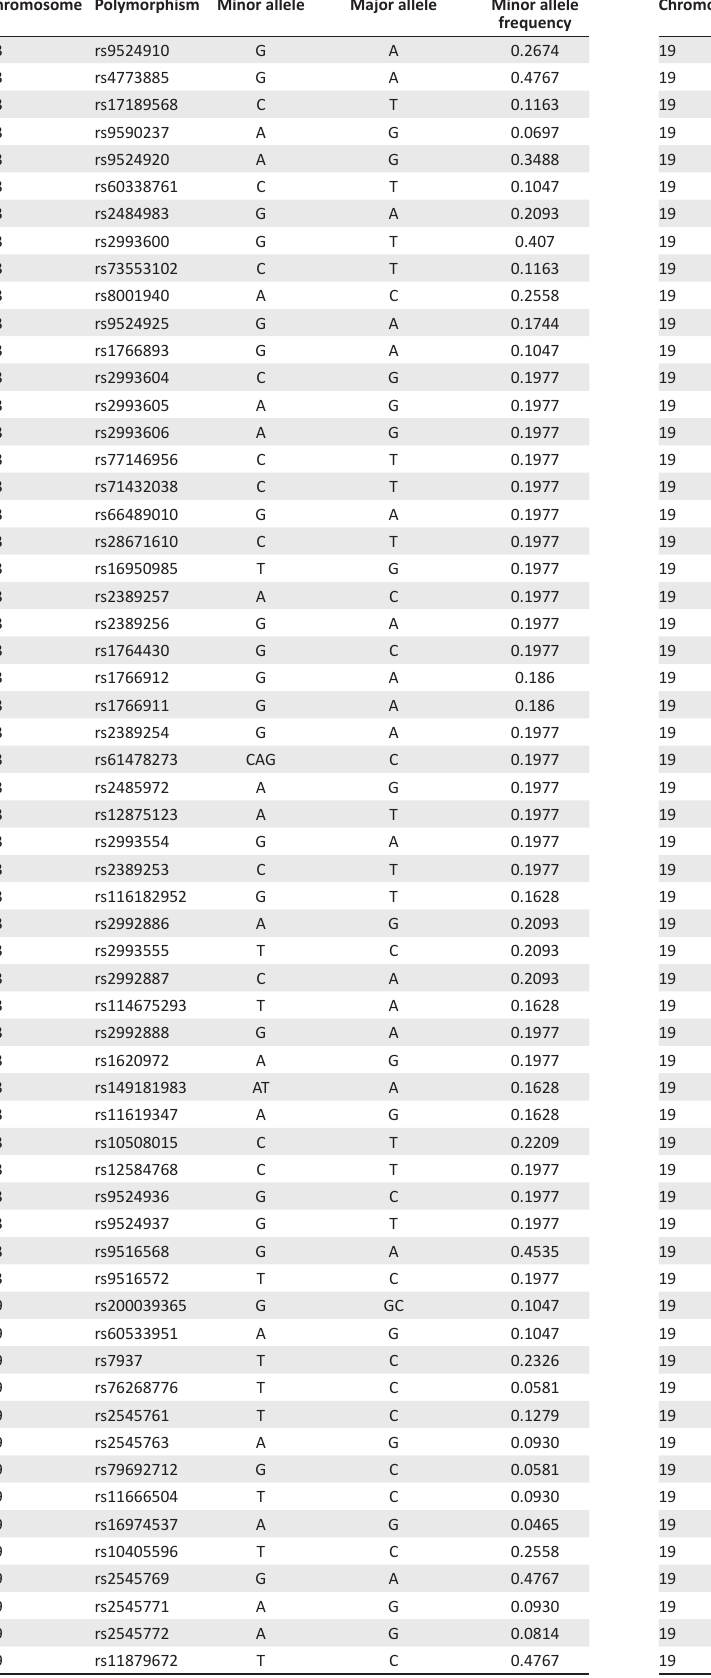
Table 1-A1 continues on the next page →Table 1-A1 continues in the next column